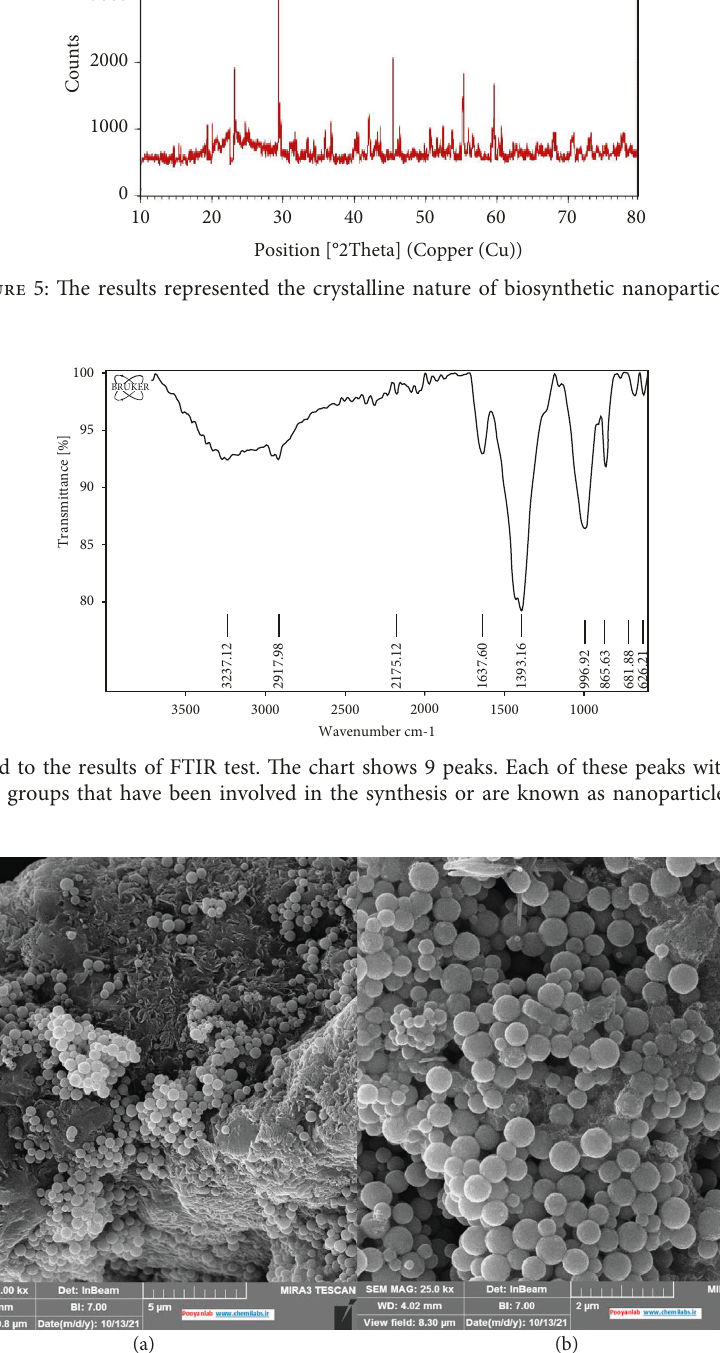
Figure 7: SEM analysis results. (a) The right figure is with a magnification of 10,000; (b) The left figure is a biosynthetic nanoparticle with a magnification of